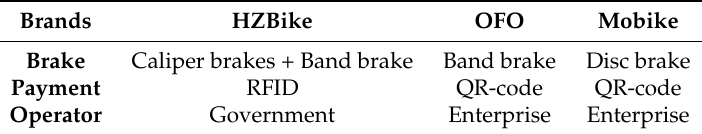
Table 7. Comparison of security on three brands [26,27,43].